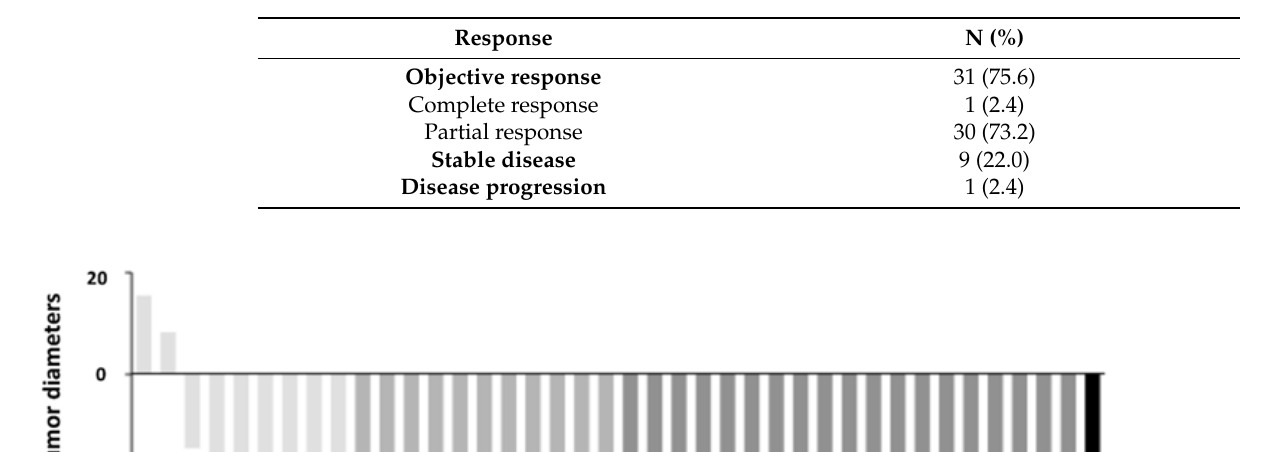
Table 3. Tumor response evaluation (according to RECIST v1.1) after induction chemotherapy among